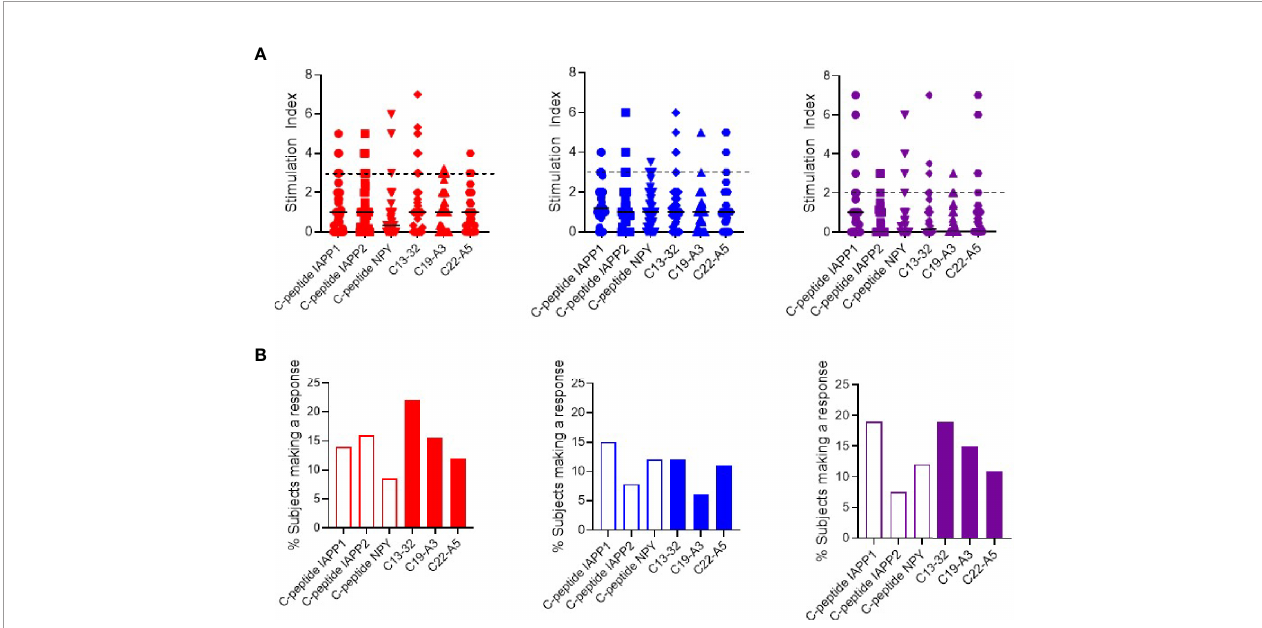
FIGURE 1 | Cytokine T cell responses were measured by ELISPOT, and data are expressed as SI [stimulation index (mean spot number of test peptide/mean spot number of diluent)]. (A) Magnitude of IFN- g (red) IL-10 (blue) and IL-17 (purple) responses in preclinical and subjects with type 1 diabetes against neo- (C-peptide- IAPP1, C-peptide-IAPP2 and C-peptide-NPY) and native epitopes (C13 – 32, C19-A3, C22-A5). The dashed line represents the cut-off for positivity for the stimulation index (three for interferon- g and IL-10 and two for IL-17). (B) Prevalence of IFN- g (red) IL-10 (blue) and IL-17 (purple) responses measured by ELISPOT in preclinical and subjects with type 1 diabetes against individual peptides of neo- (open bars) and native ( fi lled bars)